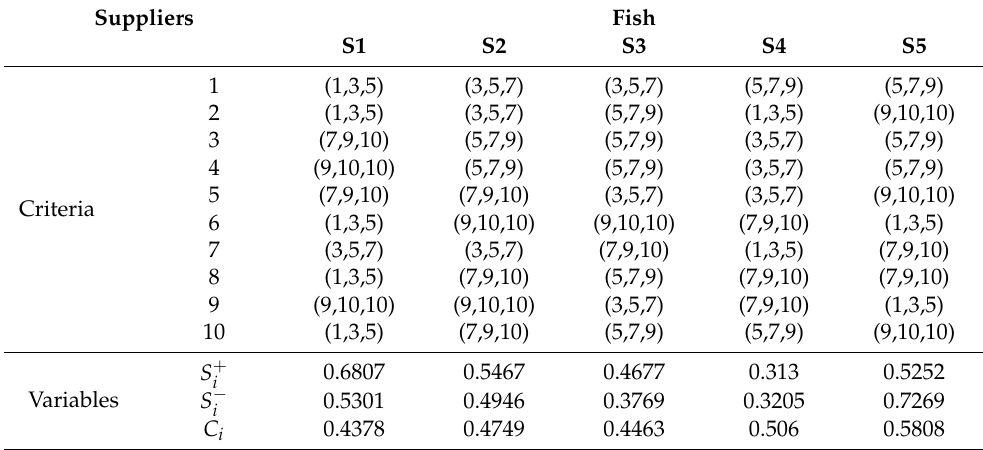
Table A21. Decision matrix considering suppliers and similarity index for fish.